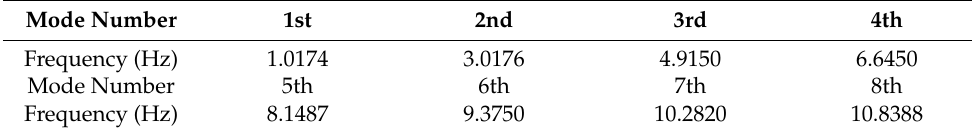
Table 1. The 8 modal frequencies of numerically simulated structure.